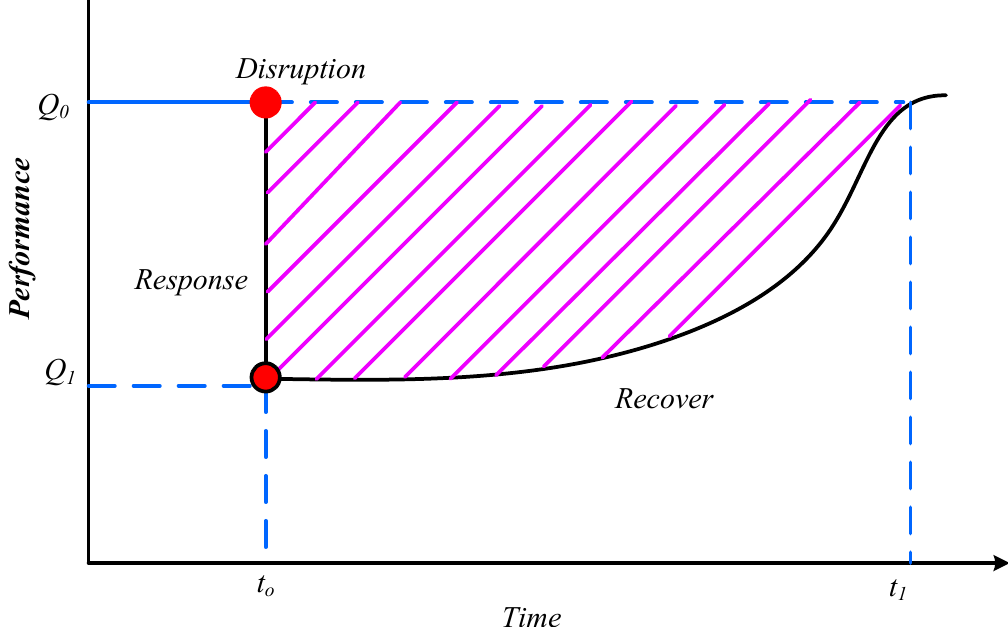
Figure 23. The schematic representation of resilience [27].